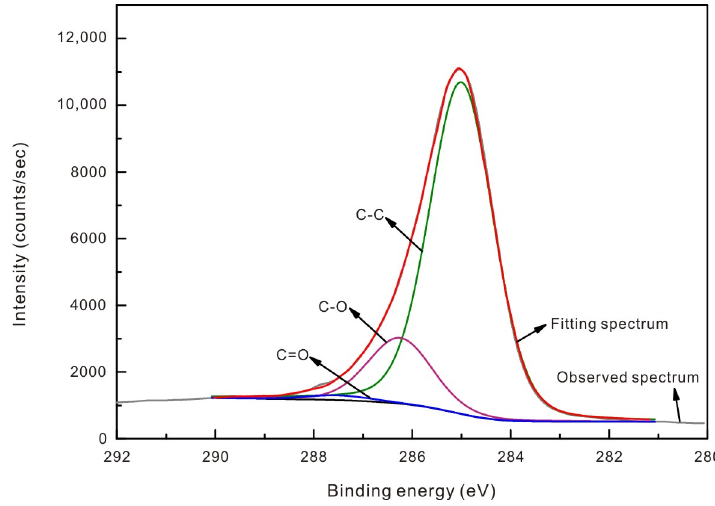
Figure 5. Example of the curve-resolved fitting of XPS C (1s) for the XS1 sample. Table 5. Surface carbon and organic oxygen content and relative abundance of functional groups.